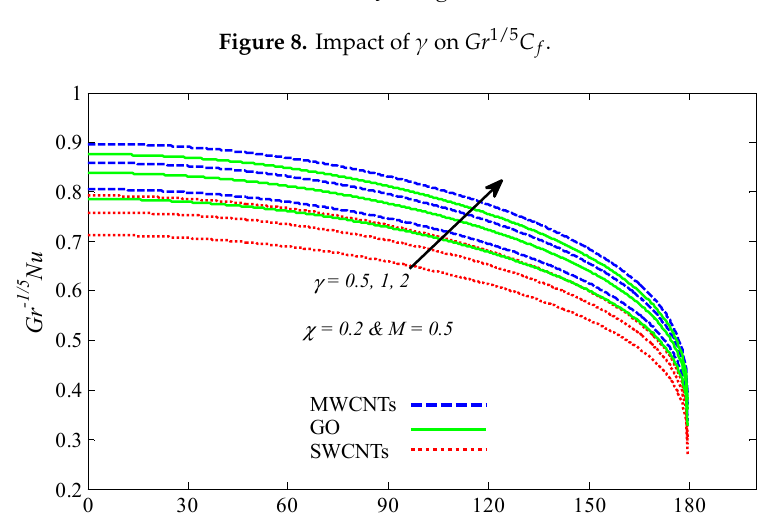
Figure 9. Impact of γ on Gr − 1/5 Nu